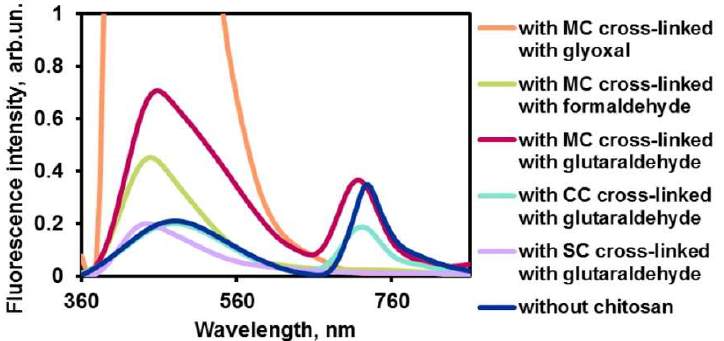
Figure 4. Fluorescence spectra of aggregates dye–ceftriaxone–PHMG–chitosan with various crosslinkers and chitosans: maleated (MC), carboxymethylated (CC), and sulfated (SC).